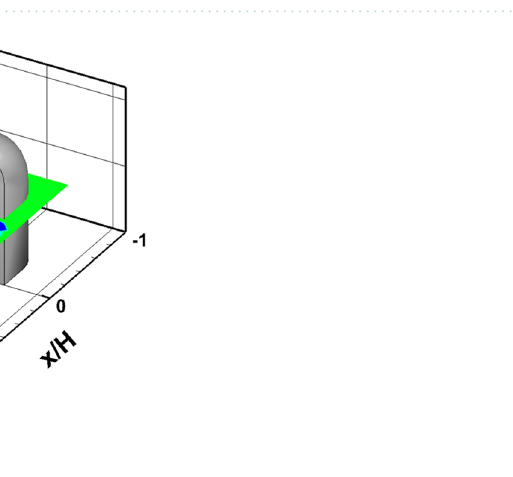
Figure 12. Measurement positions at z/H = 0.5. P1 is in the recirculation zone; P2 is located at the wake shear layer region; P3 is in the area where the trailing vortex appeared near the central region of the wake after passing the recirculation zone downstream of the